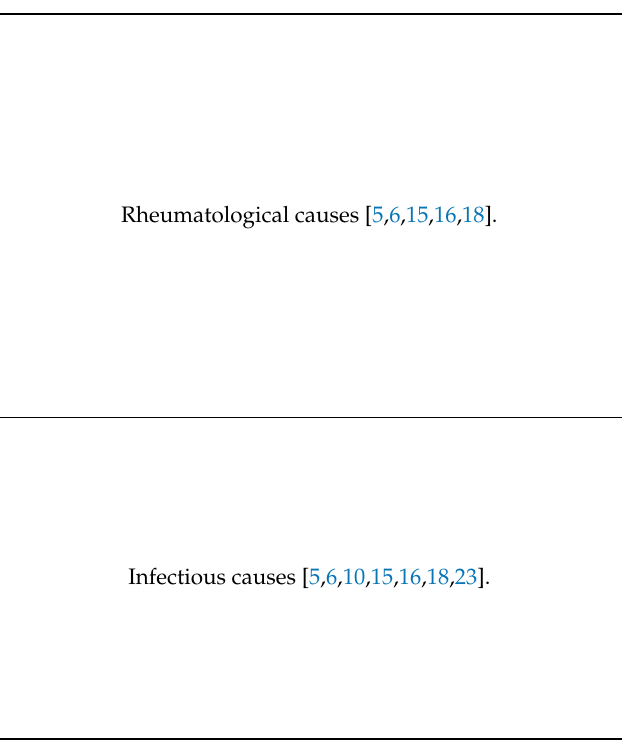
Table 2. Clinical symptoms, laboratory and radiological features specific for the conditions mimicking